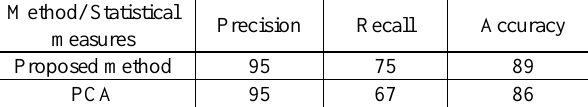
Table 8. Check point analysis results using Faro subset